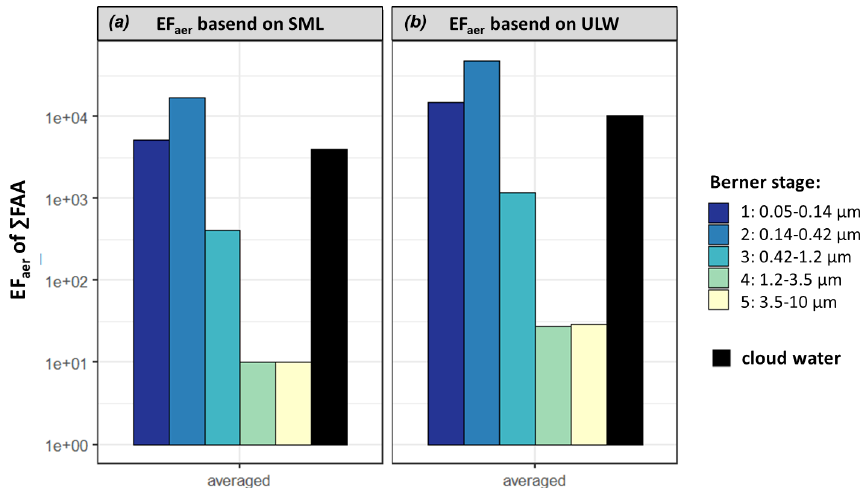
Figure 5. The averaged aerosol enrichment factor (EF aer ) of (cid:80) FAA in the size-segregated aerosol particle samples (Berner stage 1–5) at the CVAO and the cloud water enrichment factor (EF CW in black) based on SML (a) and on ULW (b) calculation (Eq.